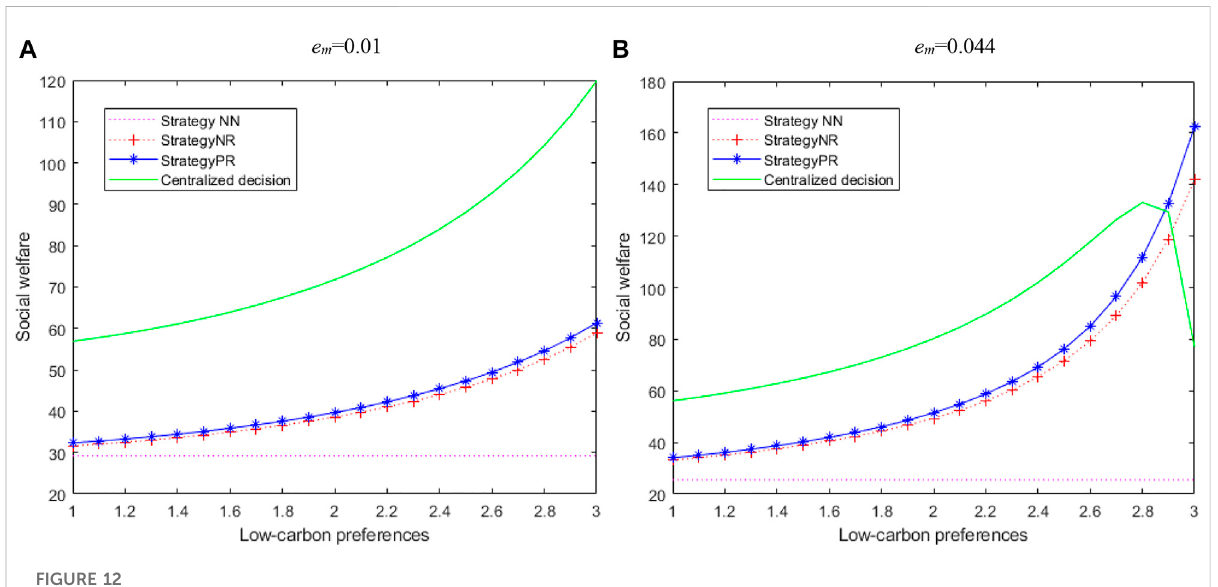
FIGURE 12 Social welfare responses to customers ’ low-carbon